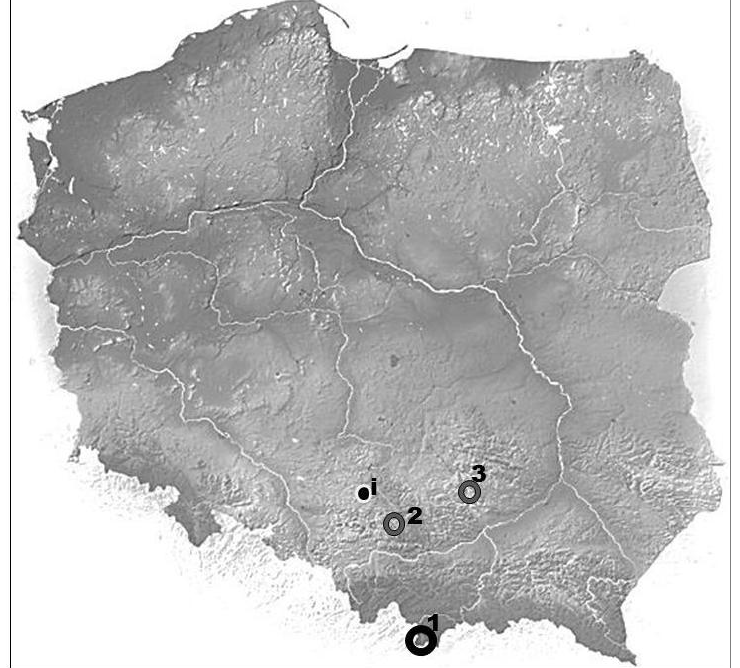
Fig. 2. The locations of the known Biscutella laevigata localities in Poland: 1 – Tatra Mts., 2 – Olkusz - Boleslaw Ore-bearing Region; 3 – Kozubów (Nida Basin), and i – the place of the introduction – Piekary Śląskie “Dołki” (Upper